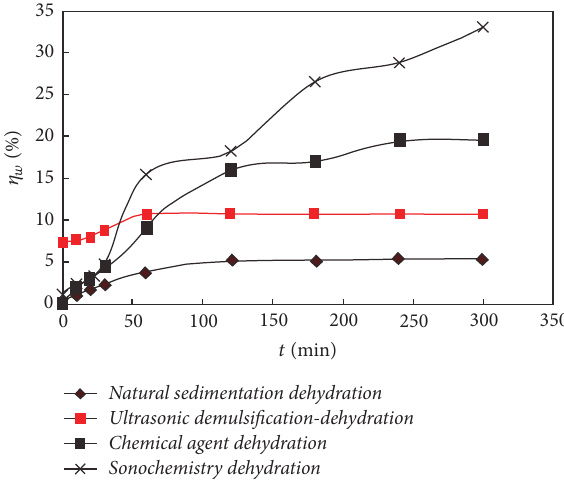
Figure 6: The comparison of demulsifying and dehydrating crude oil using ultrasonic excitation, natural sedimentation, chemical demulsifier, and sonochemistry method, respectively, at 60 ∘